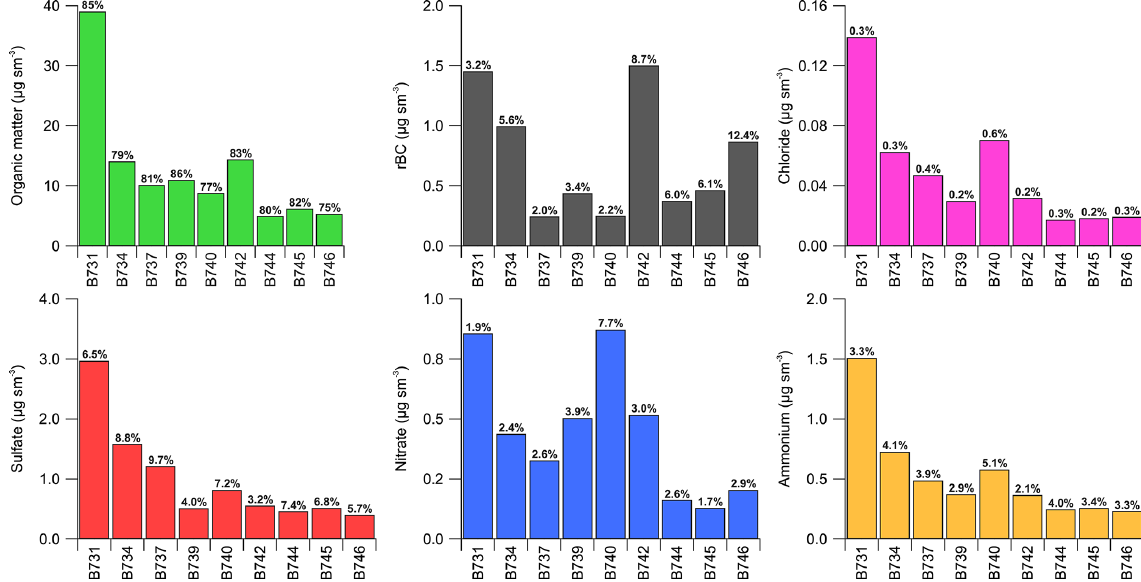
Figure 7. Sub-micrometre aerosol chemical composition overview for the regional analysis with the data split into individual flight operations in the regional boundary layer aerosol haze. Data are from straight-and-level runs (SLRs) only with the bars denoting mean concentrations and the text above each bar providing the mass fraction as a percentage. B742 took place over Tocantins, while B746 was primarily over Mato Grosso with some measurements over Rondônia. The rest of the flights were conducted over Rondônia.